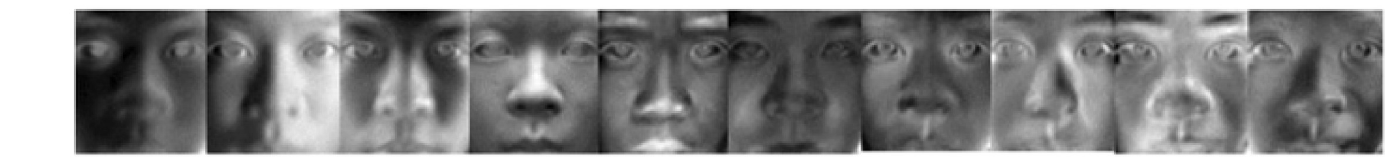
Fig 5. Eigenfaces [49].